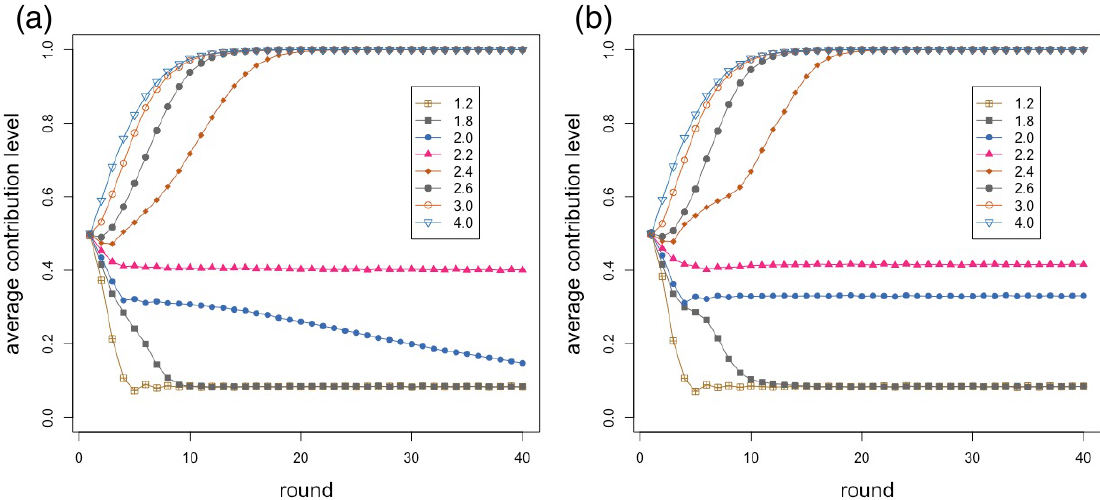
Figure 5. Average contribution as a function of round number for several values of the enhancement factor r as shown in the inset: ( a ) α = 0; and ( b ) α = 1. The average is over 40 independent repetitions of 40 rounds each on a network of size